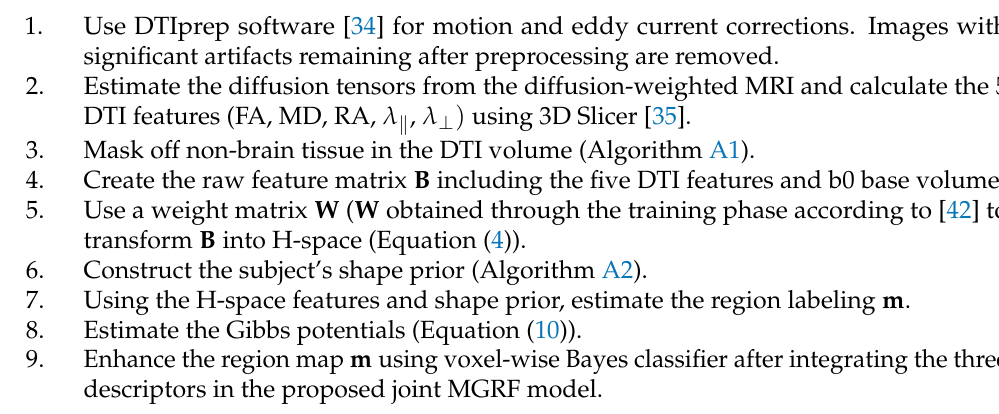
Algorithm A3 Segmentation Approach